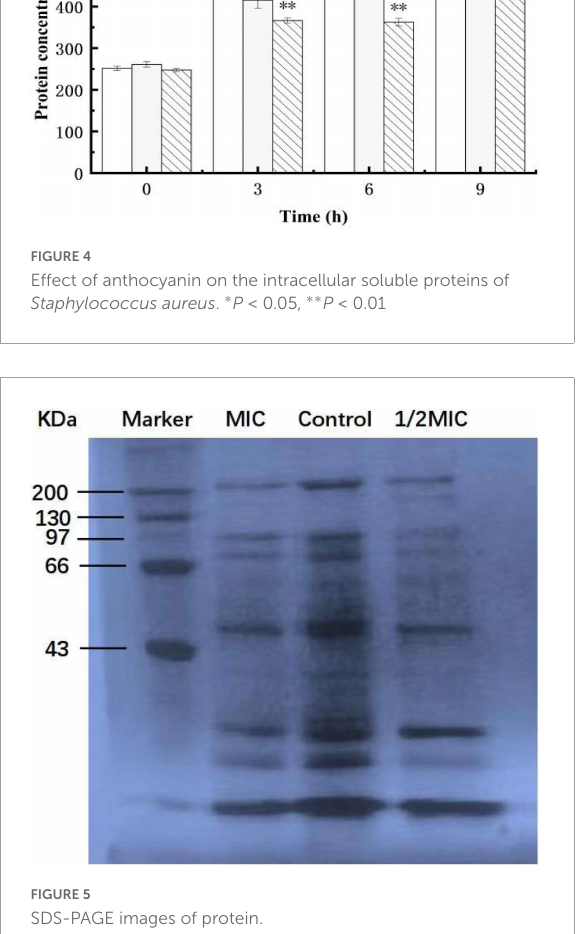
FIGURE3 Effect of anthocyanin on the extracellular K + of Staphylococcus aureus .